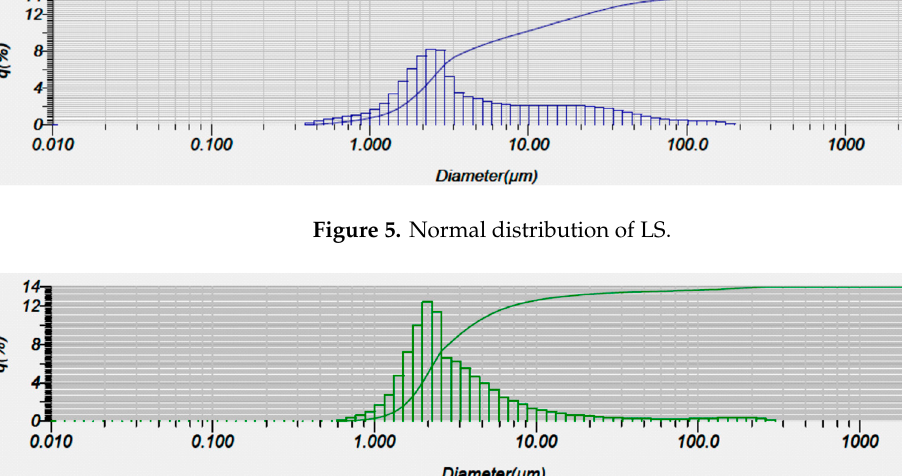
Figure 5. Normal distribution of LS.